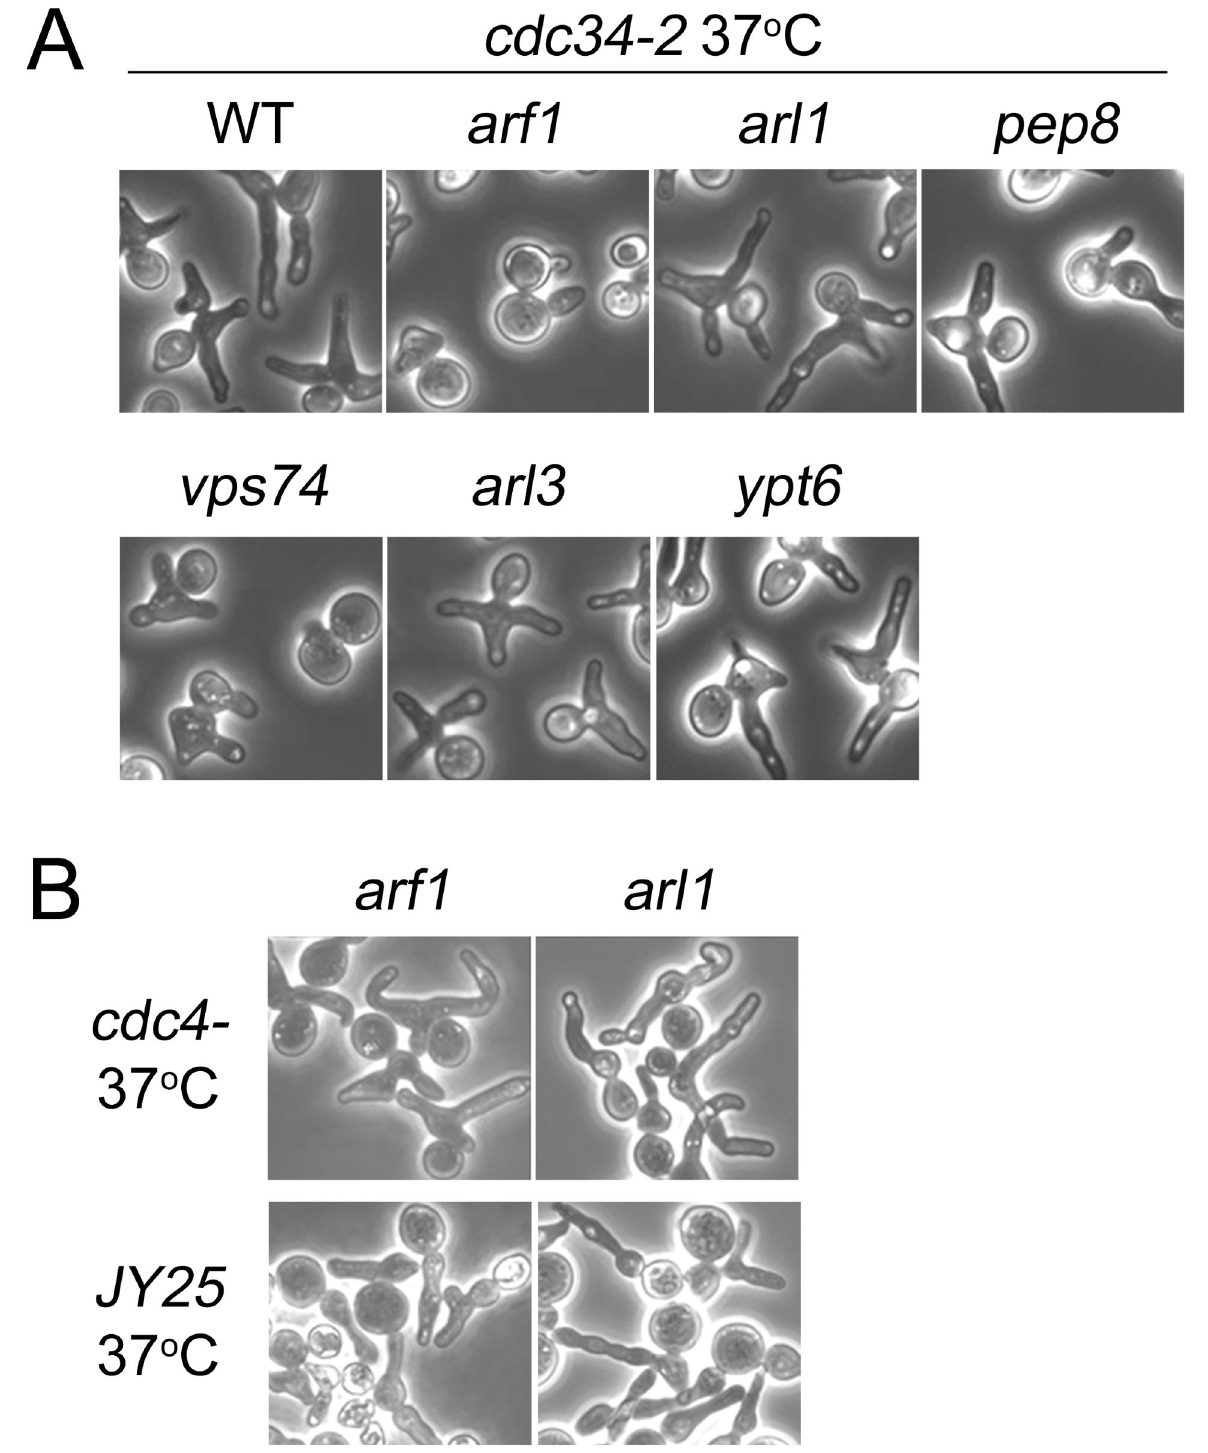
Figure 6. Arf1p facilitates elongated bud formation in cdc34-2 mutant. (A) cdc34-2, cdc34-2/vps74 Δ , cdc34-2/arf1 Δ , cdc34-2/ arl1 Δ , cdc34-2/arl3 Δ , cdc34-2/pep8 Δ, and cdc34-2/ypt6 Δ mutants (B) cdc4-/arf1 Δ , cdc34-2/arl1 Δ , JY25/arf1 Δ , and JY25/arl1 Δ mutants were grown in YPD at 25°C to an OD600 nm of 0.2, shifted to 37°C for 6 h, and imaged by microscopy.